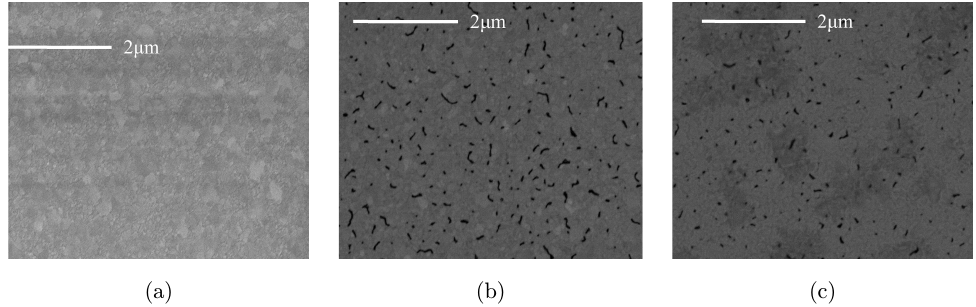
Fig. 5. (a) Micrograph of SPR chip with electron acceleration voltage of 3000 V. (b) Micrograph of SPR chip with electron acceleration voltage of 15000 V. (b) Micrograph of SPR chip with the polydopamine ¯lm with electron acceleration voltage of 15000